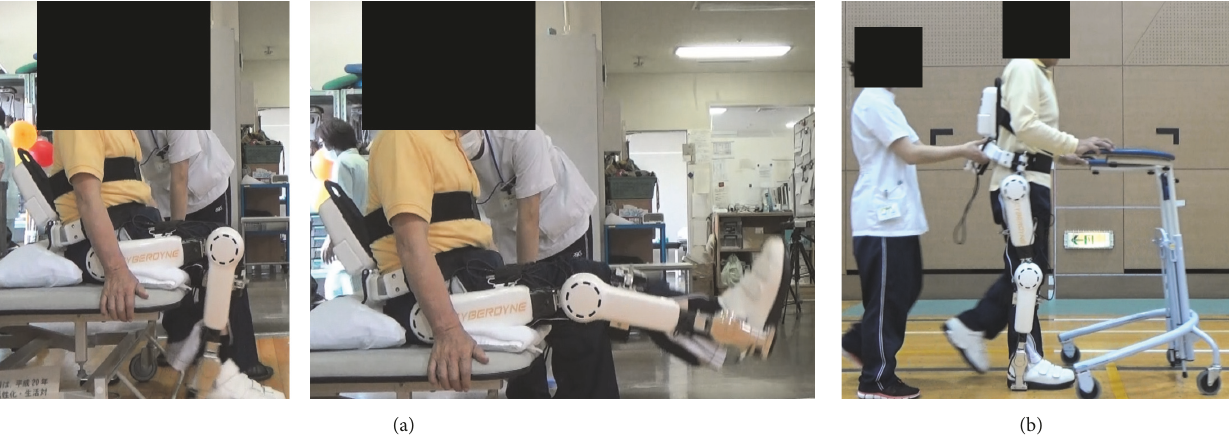
Figure 1: Photo of the hybrid assistive limb (HAL) on the patient (a). The patient is a 76-year-old male who underwent right TKA for grade 4 knee OA (Kellgren-Lawrence scale). Photo of the HAL training during walking (b).